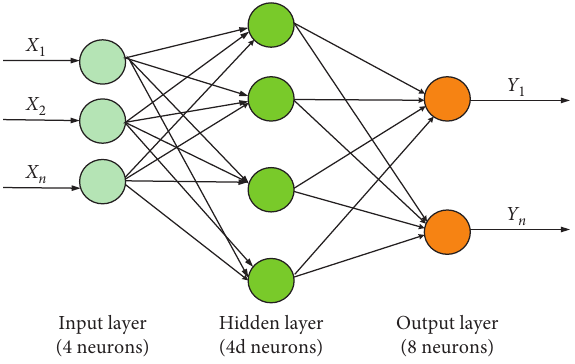
Figure 4: Structure of BP neural